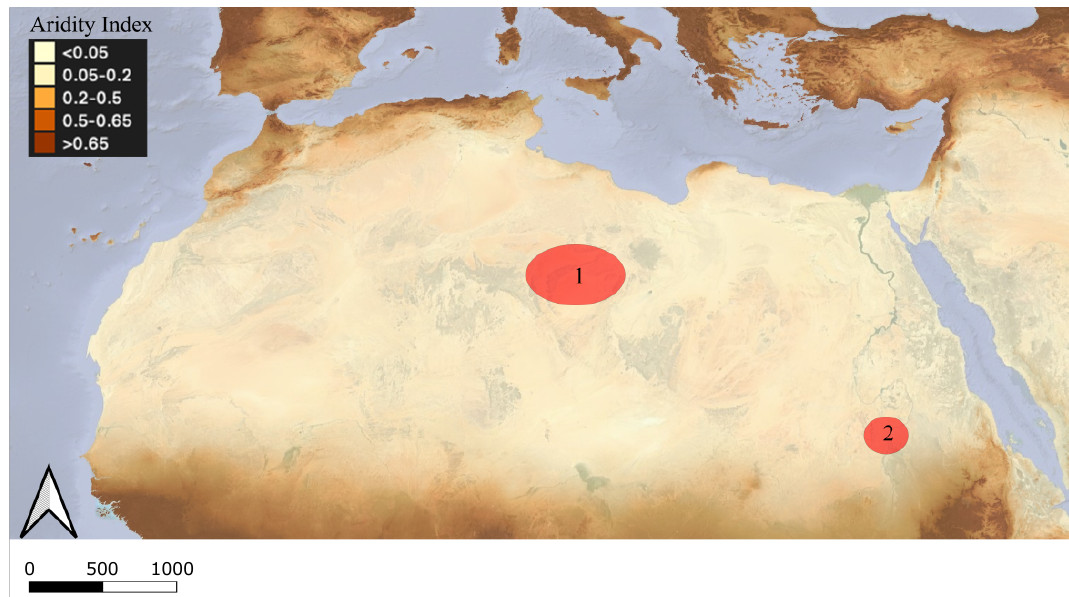
Figure 1. Aridity Index [1,2] map of the area considered in this study: ( 1 ) Fazzan; and ( 2 ) Central Sudan. Note that by using this index, our use of the term “Sahara” also encompasses areas that are not normally considered part of this desert, such as the Nile Valley and coastal areas of Egypt (map elaborated with QGIS-LTR